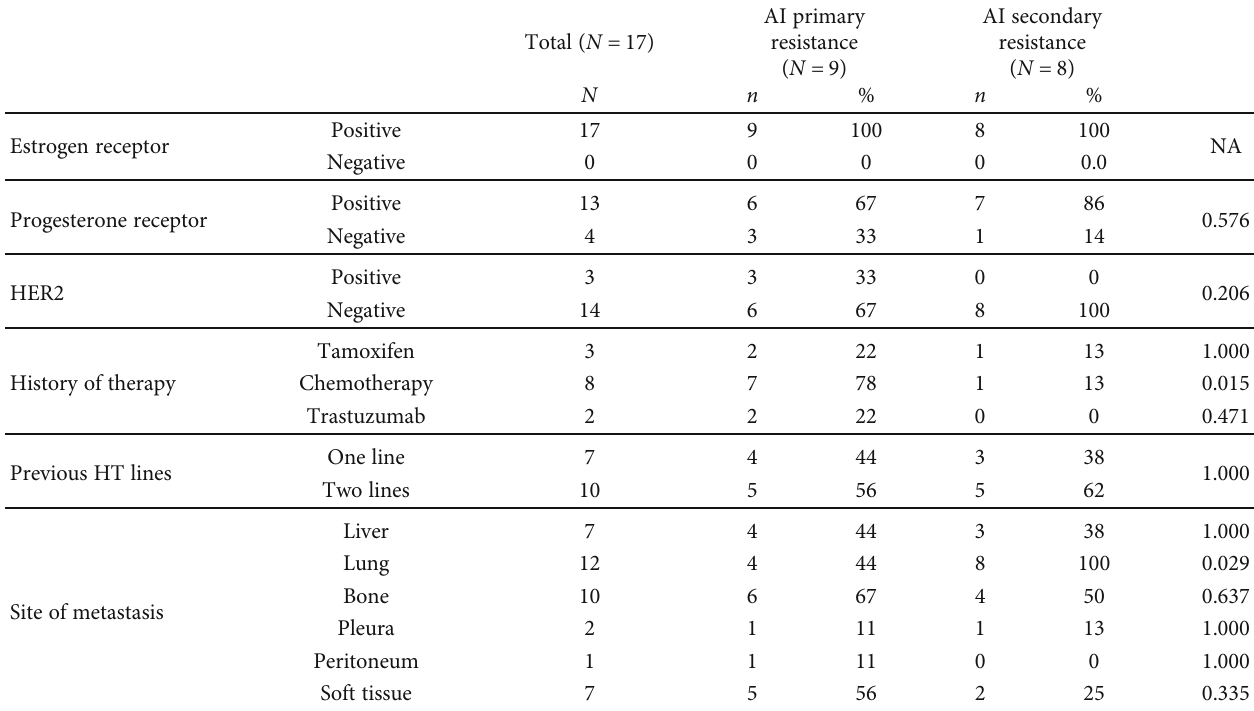
Table 3: Characteristics of primary and secondary AI resistance